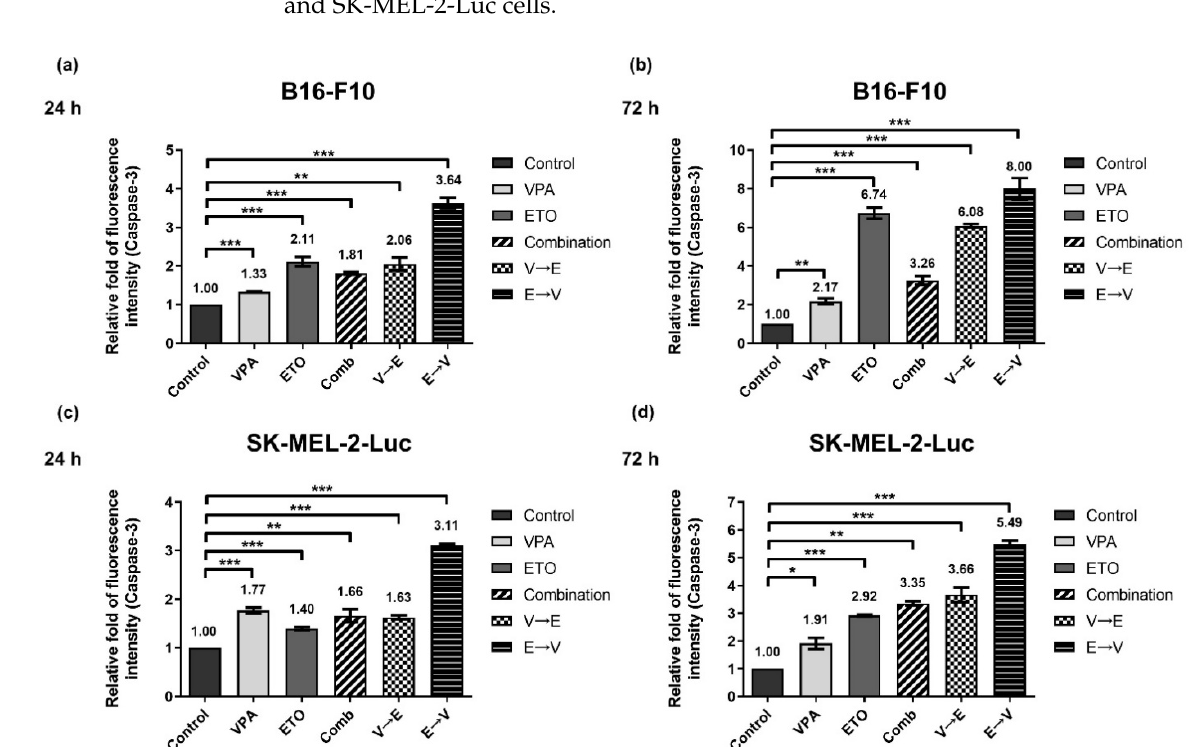
Figure 14. Caspase-3 activity analysis of single, simultaneous, and sequential combined treatments of VPA and ETO in melanoma cells. Caspase-3 activity was evaluated by flow cytometry with phycoerythrin (PE) staining. ( a ) The quantitative analysis of the caspase-3 activity of B16-F10 cells under 24 h single, simultaneous, and sequential combined treatments of VPA and ETO, and ( b ) 72 h of the specified treatment scheme was shown. The analysis was also repeated in SK-MEL-2-Luc cells, as shown in ( c , d ). The data are shown as means ± SEM of independent experiments in triplicate. (* p < 0.05; ** p < 0.01; *** p < 0.001). The drug dosages were referred to IC 50 values as shown in Figure 2 and Table 1.